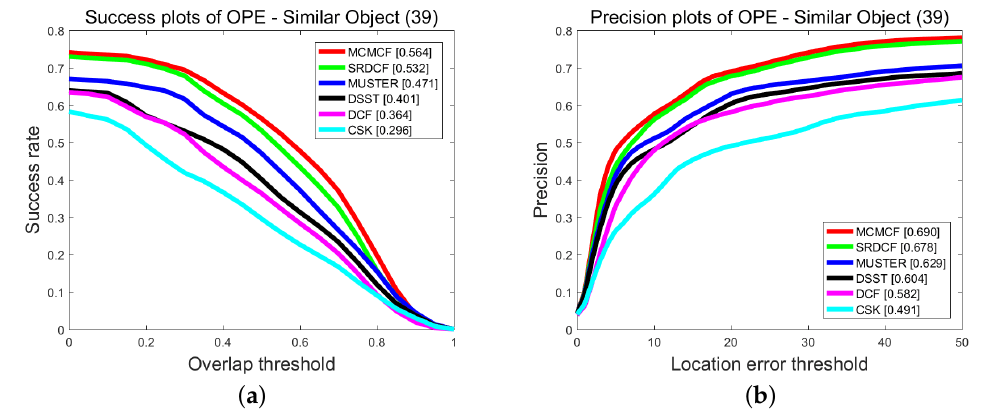
Figure 9. Comparison of success rate and accuracy with the same type of tracker on a dataset based on the presence of similar target interference in part of UAV123: ( a ) success result for models; ( b ) precision result for models.